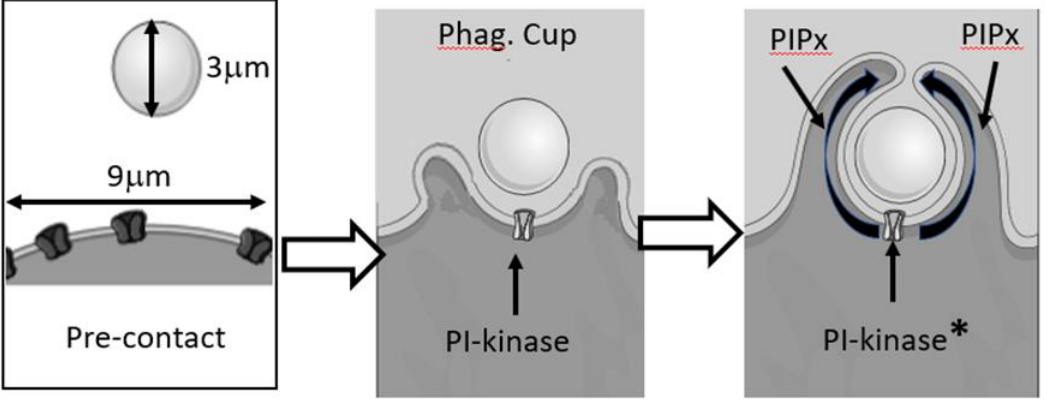
Figure 4. The lateral diffusion of signalling lipids at the site of phagocytosis.